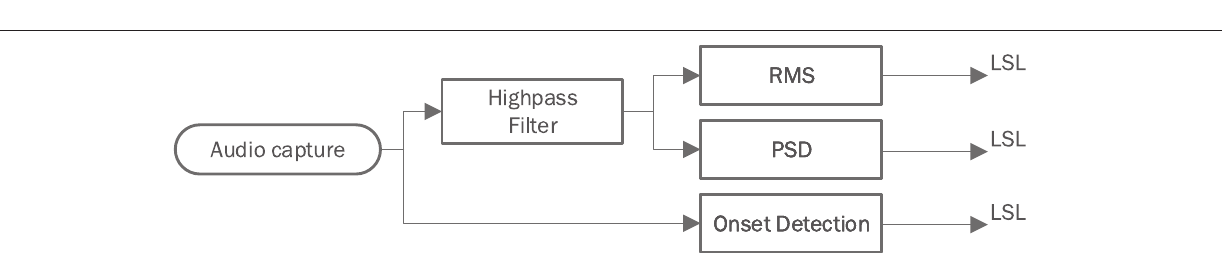
FIGURE 2 | Signal path through the different stages of the Audio Feature Extraction Framework AFEx.